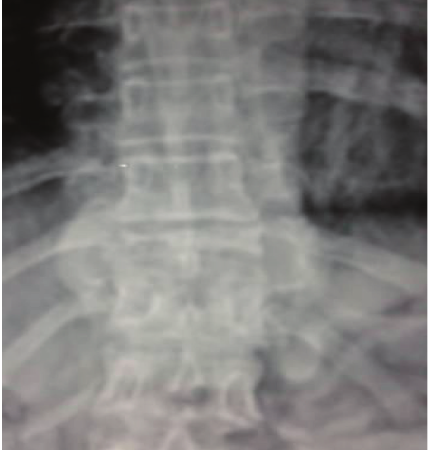
Figure 1: X-ray dorsolumbar spine showing vertebra plana of T10 vertebra. Disc space is well maintained.